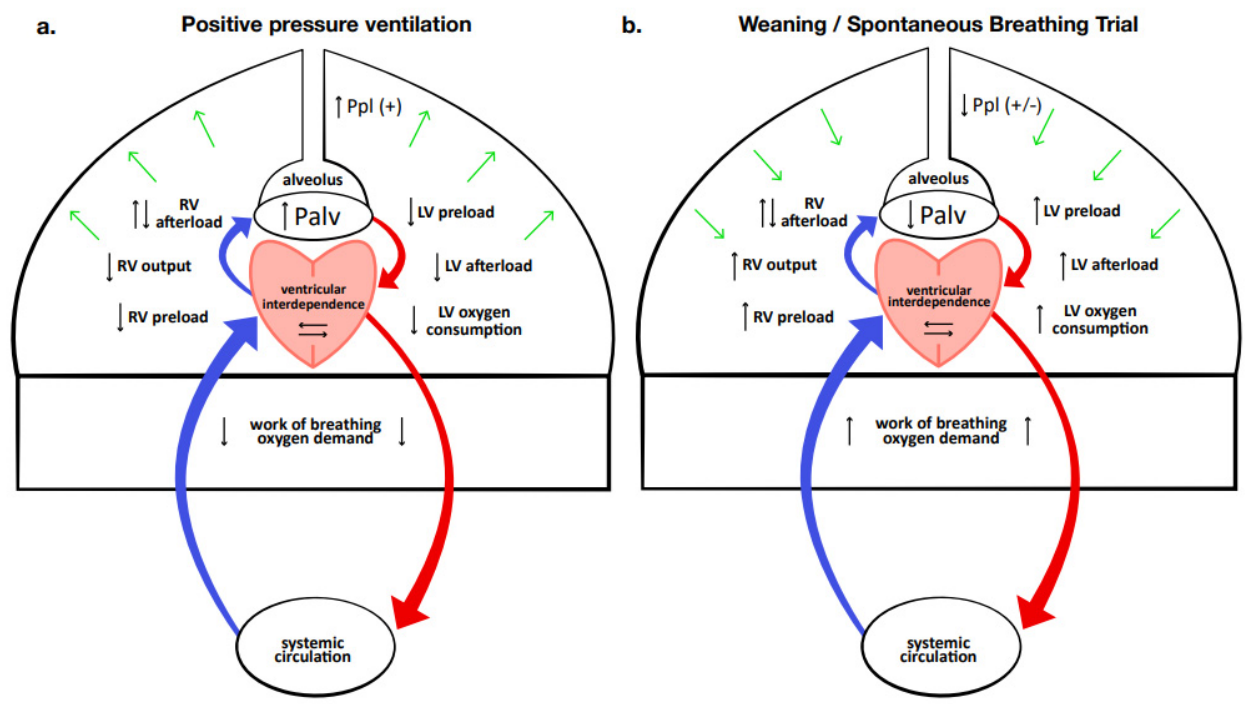
Figure 1. Heart–lung interaction, and hemodynamic effects of mechanical ventilation ( a ) and weaning/spontaneous breathing trial ( b ). During mechanical ventilation, the global effect of positive intrathoracic pressure is to reduce cardiac and global oxygen demand. During weaning and especially during spontaneous breathing trials, the reduction or abolition of positive intrathoracic pressure produces an increase in cardiac workload, while increased work of breathing, stress, and anxiety raise the global oxygen demand. Ppl, intrapleural pressure; Palv, alveolar pressure; RV, right ventricle; LV left